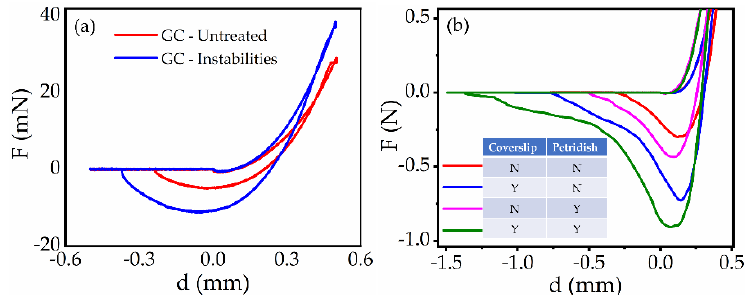
Figure A2. Adhesion tests between two silicone gel surfaces. ( a ) Force-displacement curves of the gel-coated spherical probe (16 mm) indenting gel substrates with (blue) and without instabilities (red). ( b ) Force-displacement curves of gel-coated coverslips indenting thick gel substrates. The experiments were performed under four different surface conditions. Inset table: Y indicates that the surface has instability patterns, and N indicates no instability.